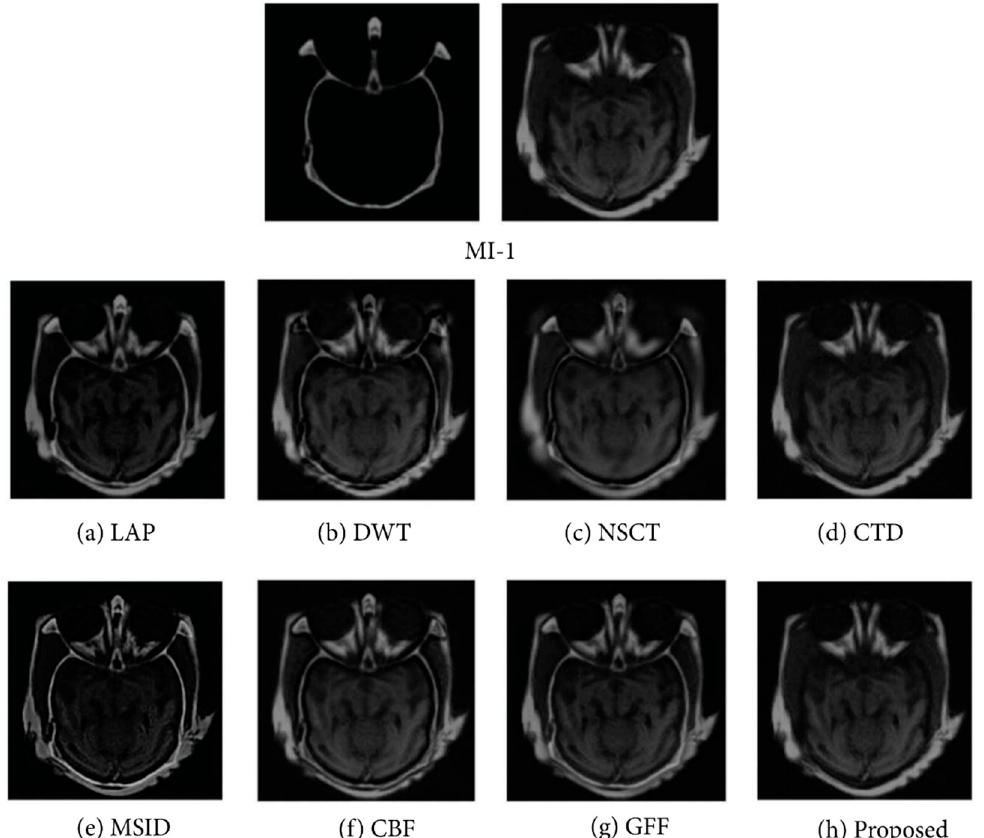
Figure 8. Outcome of the experiment “MI-1” was acquired using different fusion methods along with the proposed technique, e.g., decomposition, construction of decision map, sub-fusion of different layers, and image reconstruction. There are numerous traditional fusion methods based on mutual information levels and their associated enlarged regions. Reprinted with permission from reference [53], 2017, Zhang et al.